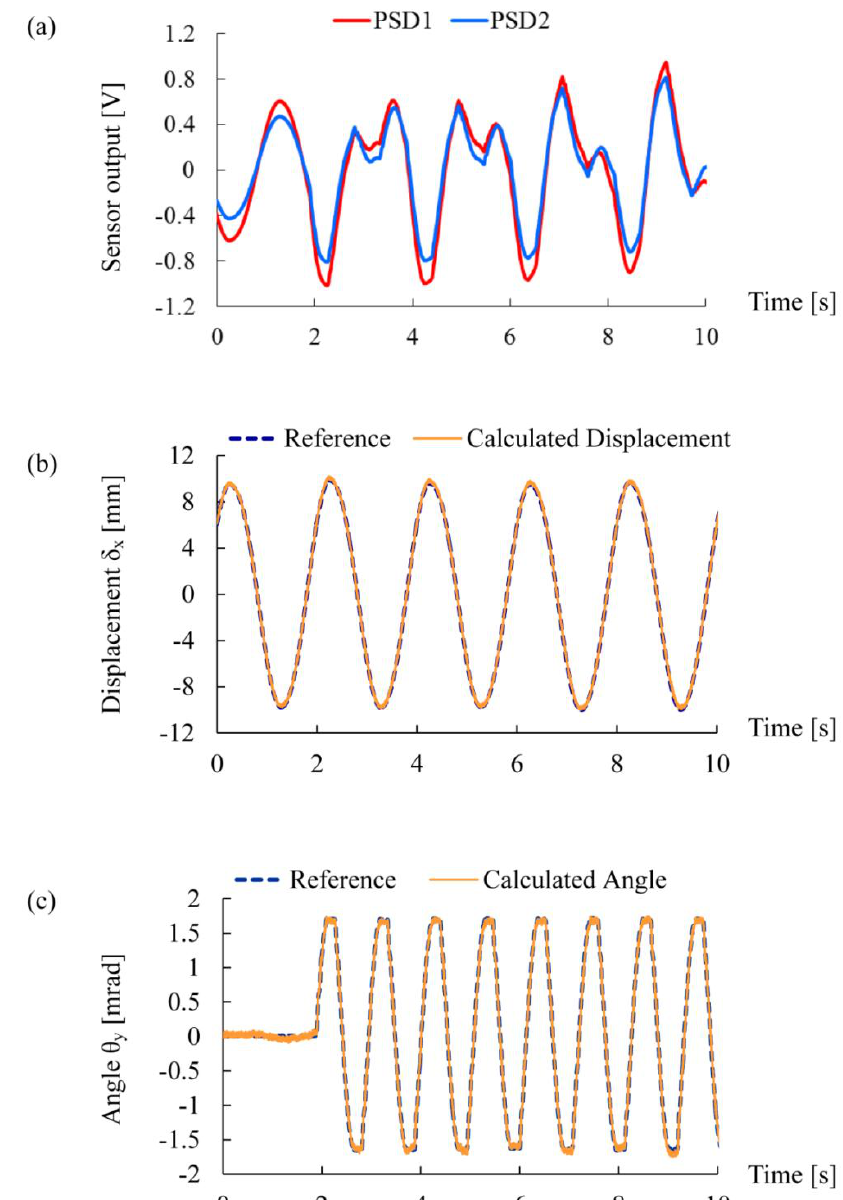
Figure 6. The results of the dynamic experiments using the shaking table and the θ -stage. (a) The output voltages from PSDs; (b) the calculated displacement δ calculated angle θ y